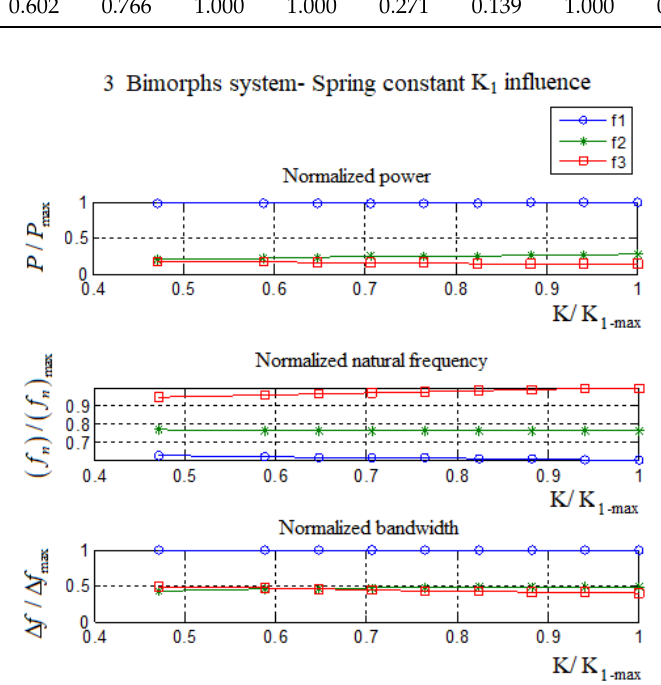
Figure A11. The influence of the normalized spring constant, K 1 on the output harvested power, natural frequency, and bandwidth (all normalized)—three bimorphs interconnected by two springs case.